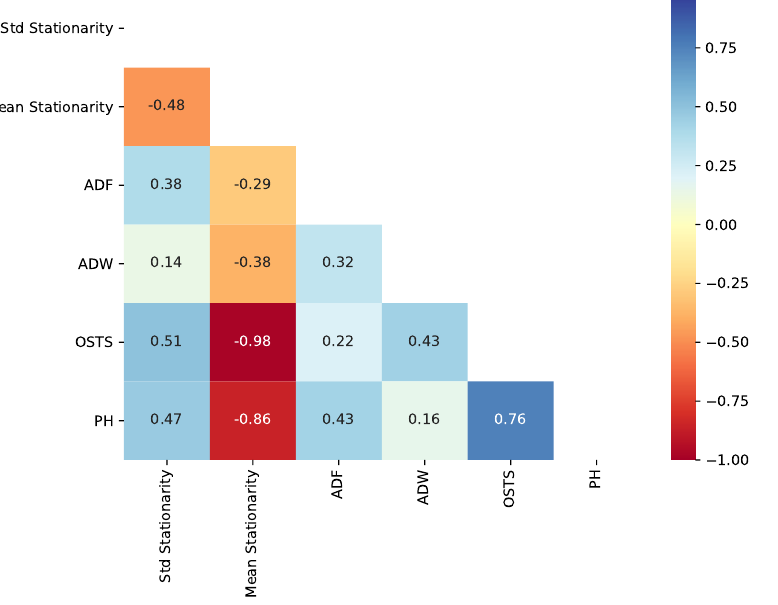
Figure 11. Correlation between the stationarity (based on ADF Test) and dimension reduction delivered by segmentation